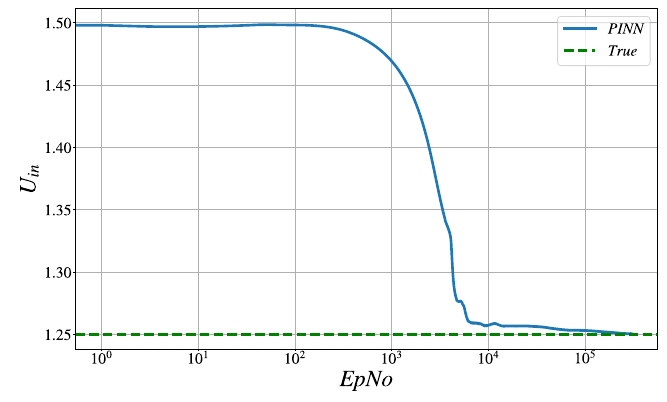
Fig. 6 The PINN approximation of the U (cid:13) in